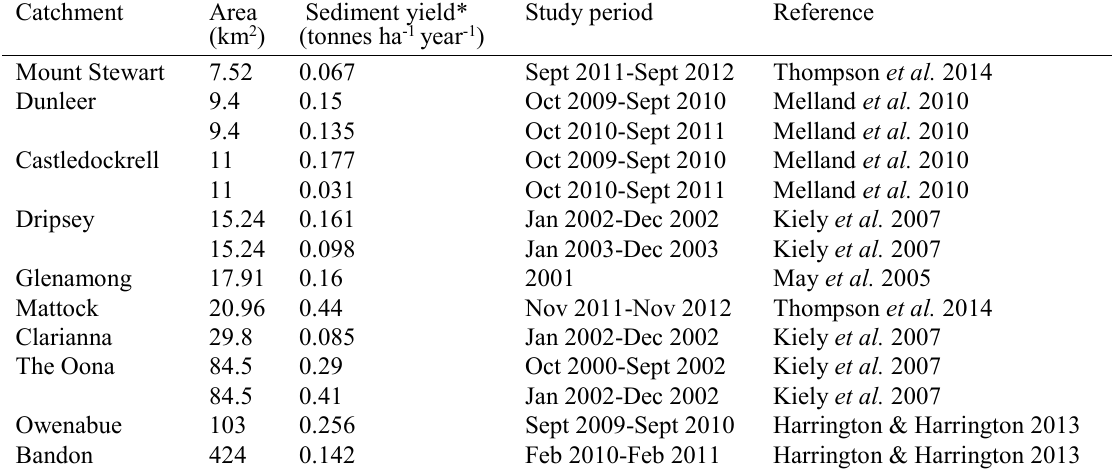
Table 1 Suspended sediment yield data in